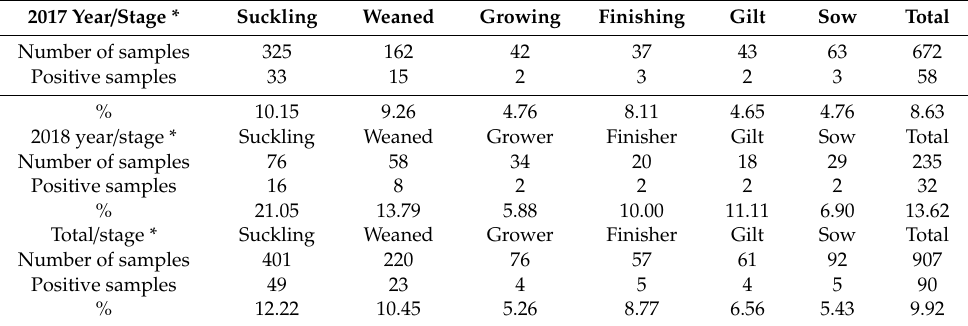
Table 2. Detection results of PEDV according to each stage from 2017 to